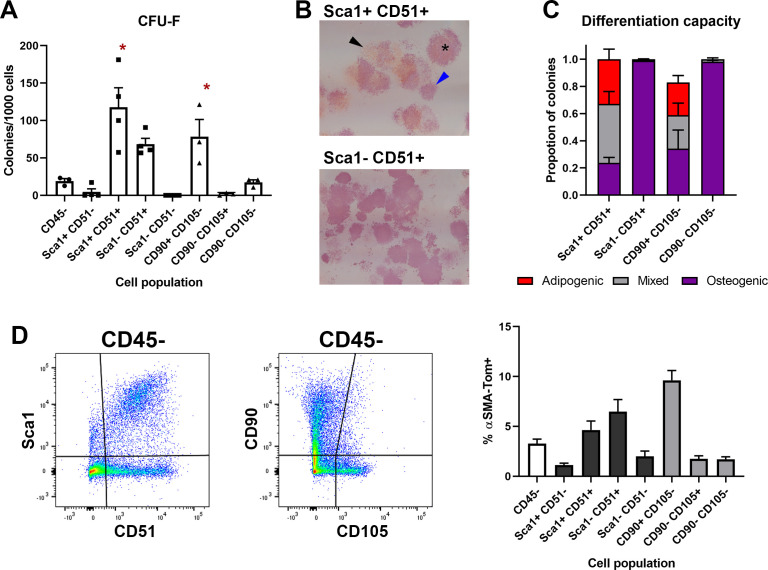
Sca1+CD51+ and CD90+ periosteal mesenchymal cells are enriched for multipotent progenitor cells.(A) Colony-forming unit fibroblast (CFU-F) formation of different CD45- periosteal populations (n = 3–4). *p<0.05 compared to total CD45- based on one-way ANOVA with Dunnett’s posttest. (B) Differentiation potential of cell populations grown in mixed osteogenic adipogenic conditions. Pink is ALP stain, red is Oil Red O, colonies indicated show osteogenic only (blue arrowhead), adipogenic only (black arrowhead), and mixed (*) colonies. (C) Quantification of colony differentiation from different populations. (D) Dot plots indicating different populations sorted and analyzed and percentage of αSMA+ cells (Tom+ cells 2–3 days after tamoxifen injection) within each of the CD45- cell populations indicated (n = 10–16).